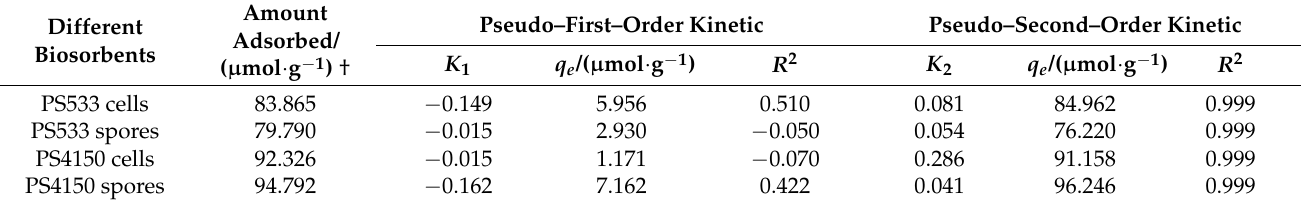
Table 1. Adsorption kinetic model parameters of Tb(III) by B. subtilis .